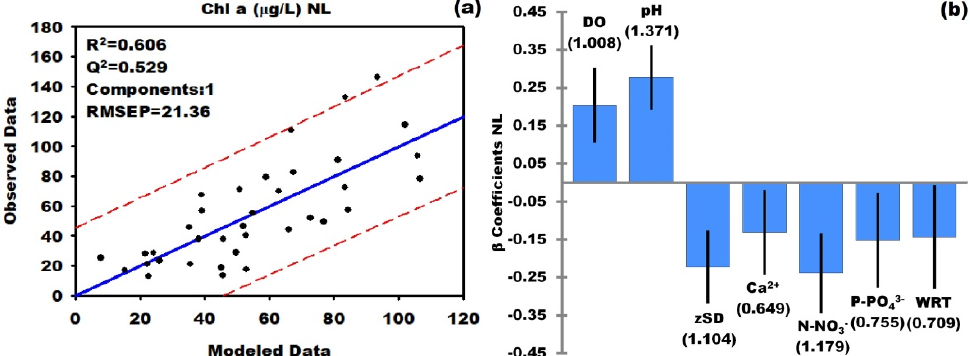
Figure 3. ( a ) Modeled vs. observed data of NL Chl a, regression line (solid line), 95% prediction confidence intervals (dashed lines), and model performance metrics; ( b ) NL β coefficients for retained variables (bars), confidence intervals (solid lines), and variable importance in projection (VIP) in parentheses.